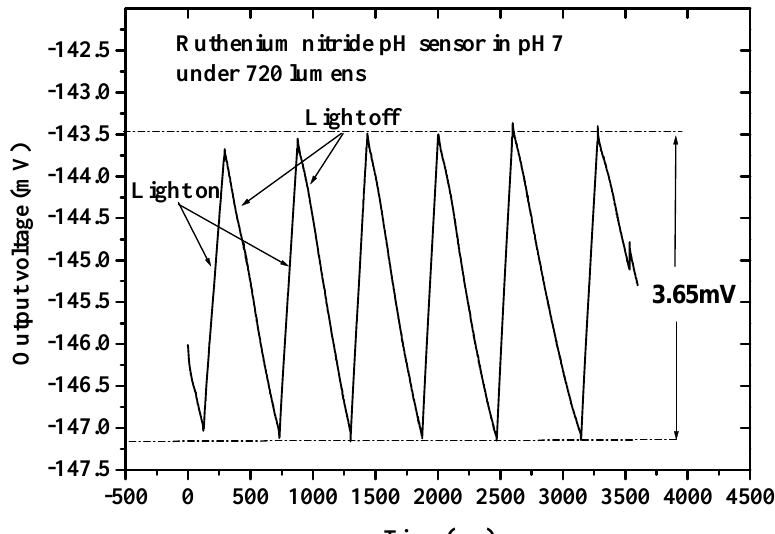
Figure 6. Drift with light influence of RuN thin film pH